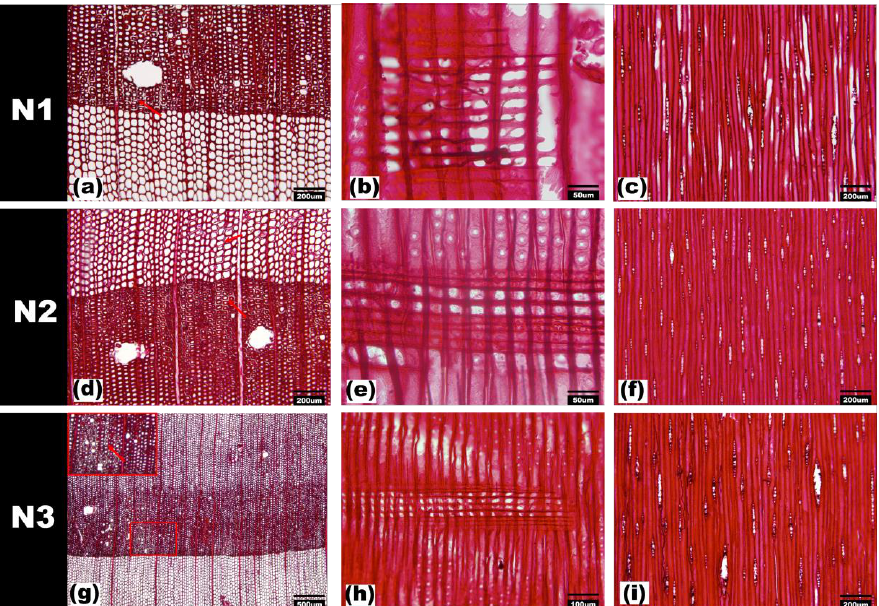
Figure 5. Anatomical structure of archaeological wood under an optical microscope. The cross- section, radial section, and tangential section of N1 were shown in ( a – c ), N2 in ( d – f ), and N3 in ( g – i ). It could be seen in ( a , d , g ) that the cell wall of some cells was separated from the intercellular layer, as indicated by the